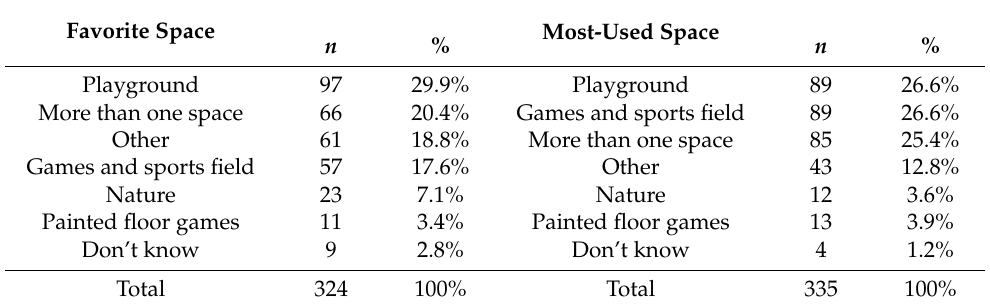
Table 2. Favorite and most-used spaces in primary school recess in the